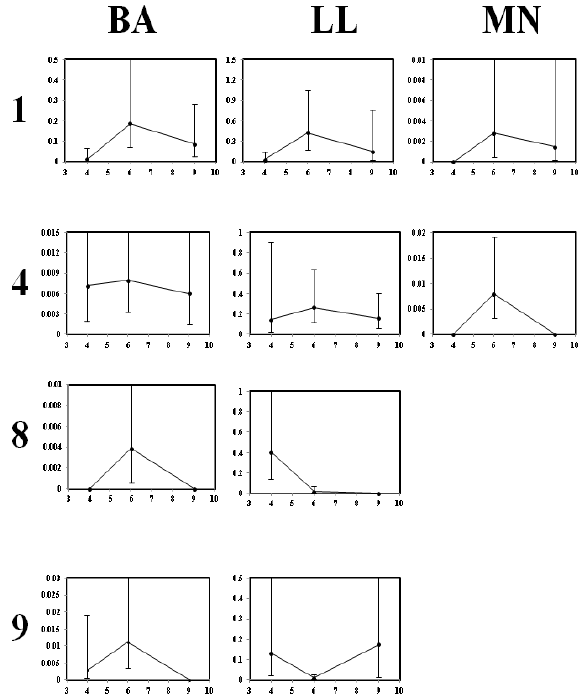
Figure 14. Seasonal change in relative abundance (uncorrected line transect density, whales nm -2 ) by stratum and species. Survey month on X-axis. BA – common minke whale; LL – white-beaked dolphin; MN – humpback whale. Trend in